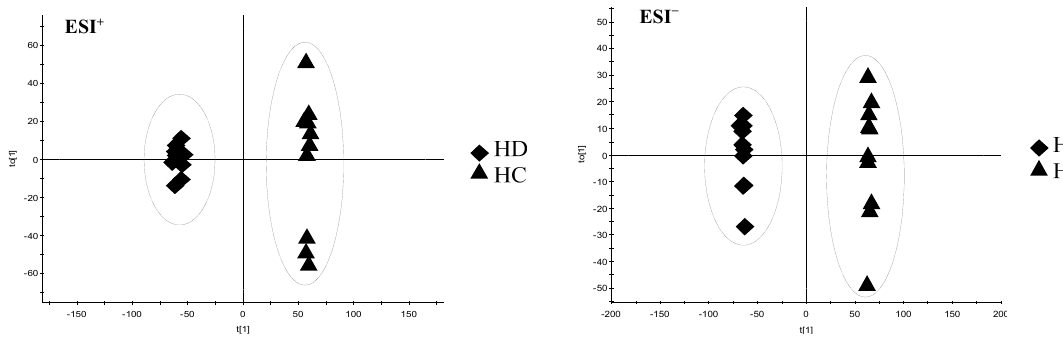
Figure 4. The OPLS ‐ DA of HC and HD in positive mode (ESI + ) and negative mode (ESI − ). Figure 4. The OPLS-DA of HC and HD in positive mode (ESI + ) and negative mode (ESI −